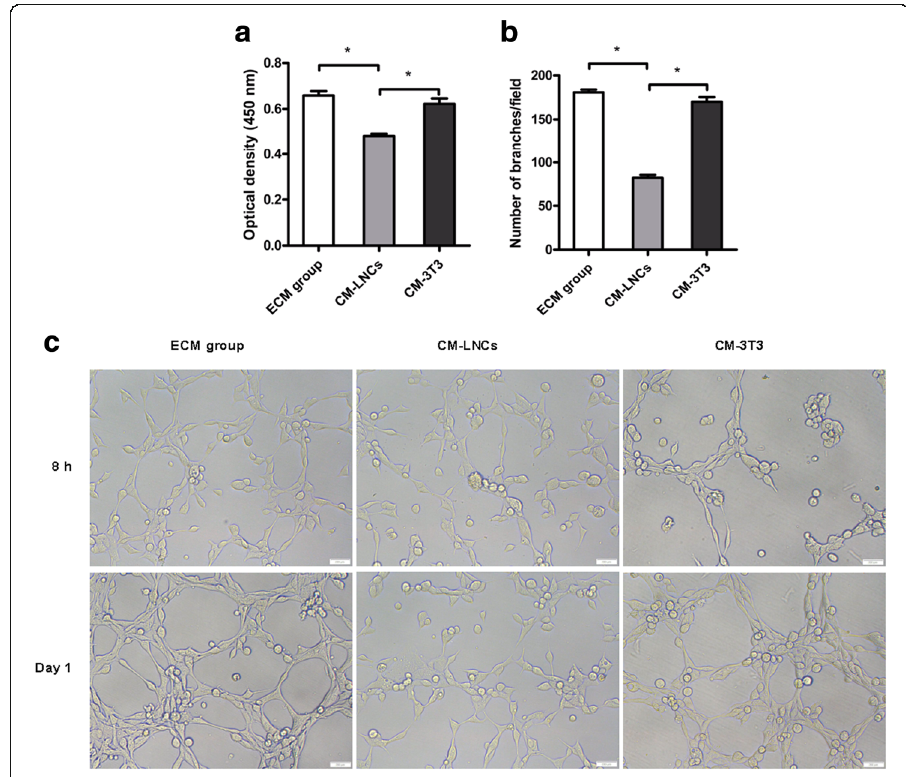
Fig. 7 Cell viability assay and tube formation assay with human umbilical vein endothelial cells (HUVECs). HUVECs were cultured in conditioned medium of cultivated oral mucosal epithelial cells (COMECs) co-cultured with LNCs (CM-LNCs) and 3 T3 cells (CM-3T3s). Cell viability ( a ) and tube formation ( b, c ) of HUVECs were assessed. HUVECs cultured in Endothelial Cell Medium (ECM group) were used as control. c Micrographs of the tube-like structures in ECM group, CM-LNCs and CM-3T3s were captured. The results were expressed as mean ± standard deviation. LNCs: limbal niche cells, scale bars: 200 μ m, *: p <